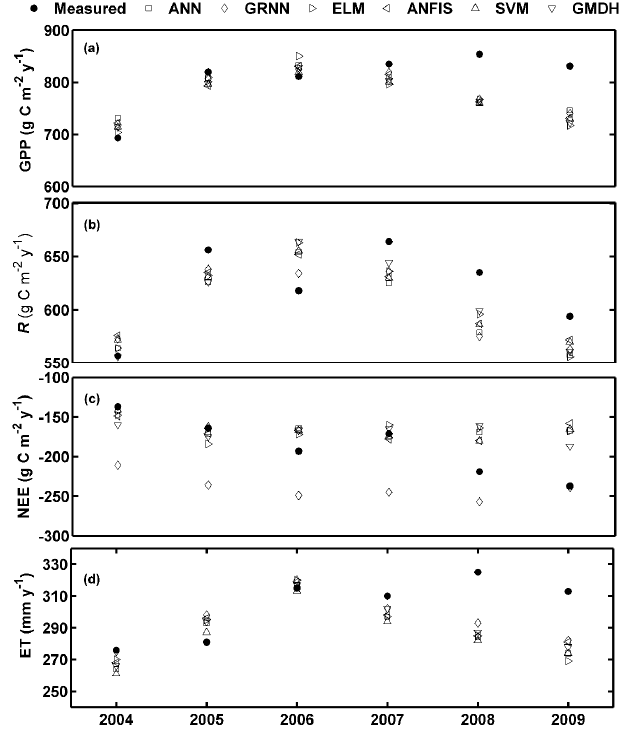
Figure 4. Comparisons of annual total carbon and water fluxes measured by eddy covariance technique and predicted by data-driven models in the whole period. ( a ) GPP; ( b ) R ; ( c ) NEE; and ( d ) ET.